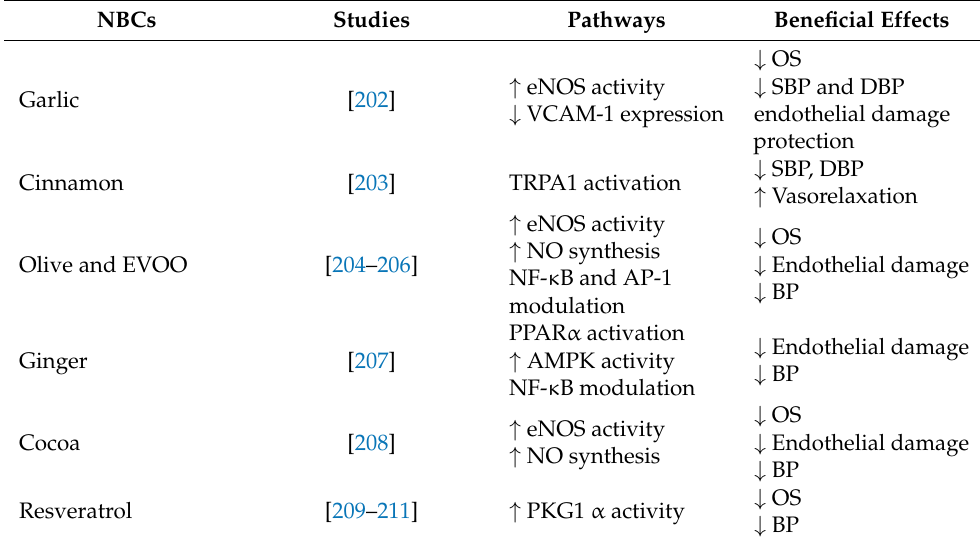
Table 4. NBCs in endothelial dysfunction